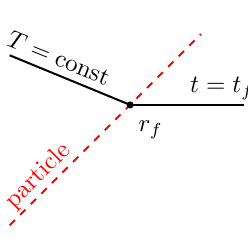
Figure 9 . The (cid:12)nal Cauchy